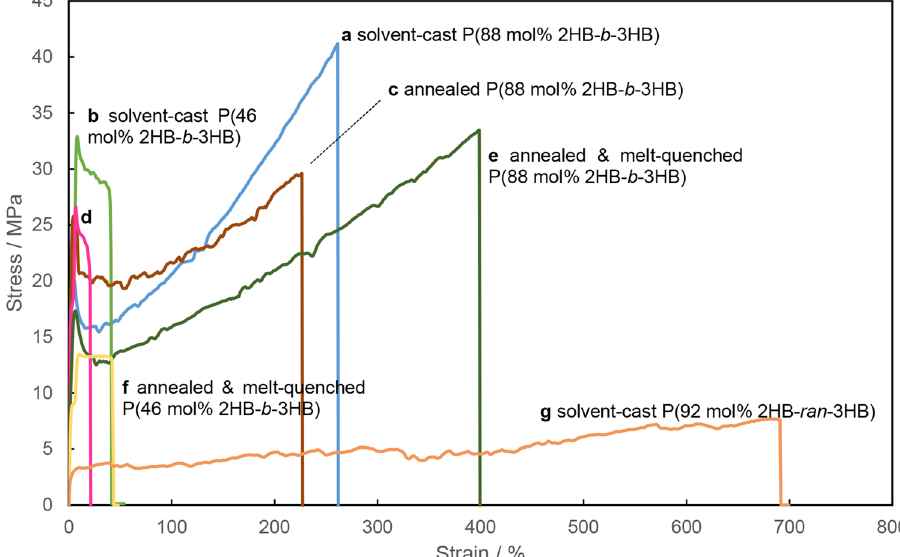
Figure 3. Stress–strain curves of the P(2HB- b -3HB) and P(2HB- ran -3HB) films. ( a) solvent-cast P(88 mol% 2HB- b -3HB) (blue), ( b) solvent-cast P(46 mol% 2HB- b -3HB) (light green), ( c) annealed P(88 mol% 2HB- b - 3HB) (brown), ( d) annealed P(46 mol% 2HB- b -3HB) (pink), ( e ) P(88 mol% 2HB- b -3HB) annealed and melt- quenched (dark green), ( f ) P(46 mol% 2HB- b -3HB) annealed and melt-quenched (yellow), ( g ) solvent-cast P(92 mol% 2HB- ran -3HB) (orange). All tests were performed at 25 °C. The increasing stress during the period of elongation indicates the elastic properties of the